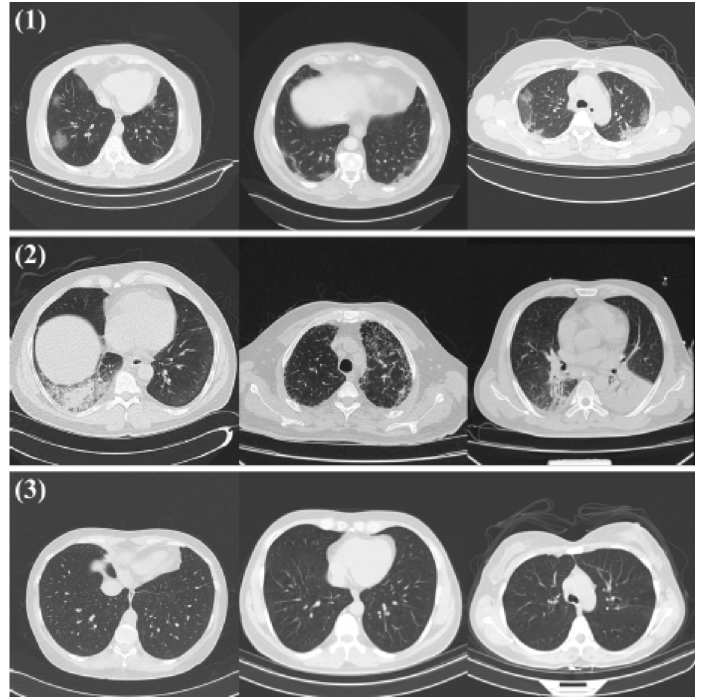
Figure 2. Sample CT images from the COVIDx CT dataset. From top to bottom, the images in ( 1 ) represent coronavirus pneumonia due to SARS-CoV-2 infection (NCP), ( 2 ) are common pneumonia (CP), and ( 3 ) are healthy lungs. Images are courtesy of [54].